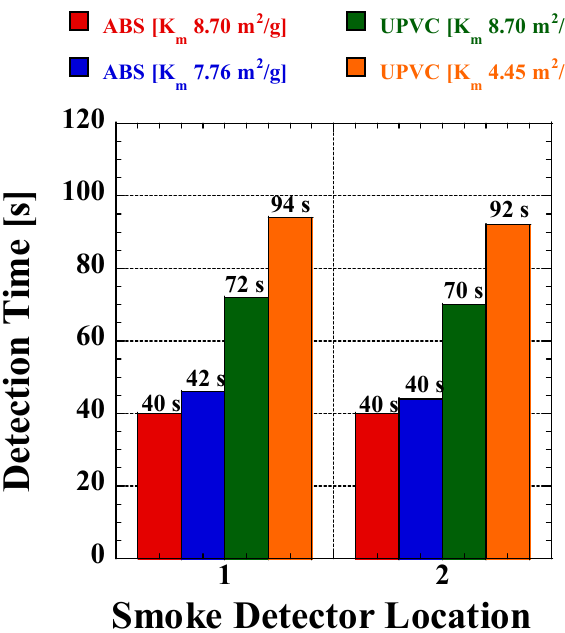
Figure 11. Comparison of alarm time calculated for ABS and UPVC combustion cases.